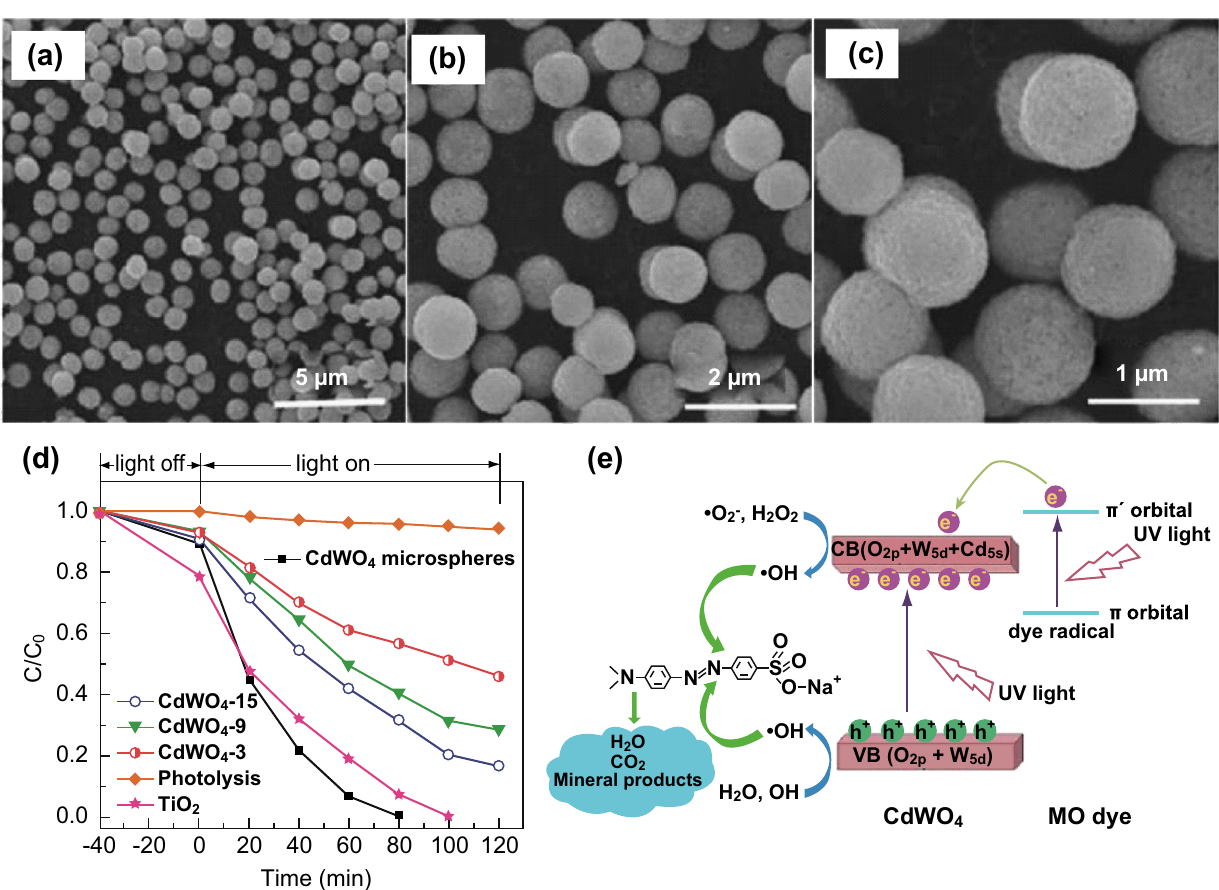
Fig. 9 a–c FESEM images of CdWO 4 microspheres. d Photocatalytic degradation efficiencies of MO in the presence of different photocatalysts. e Photocatalytic mechanism for